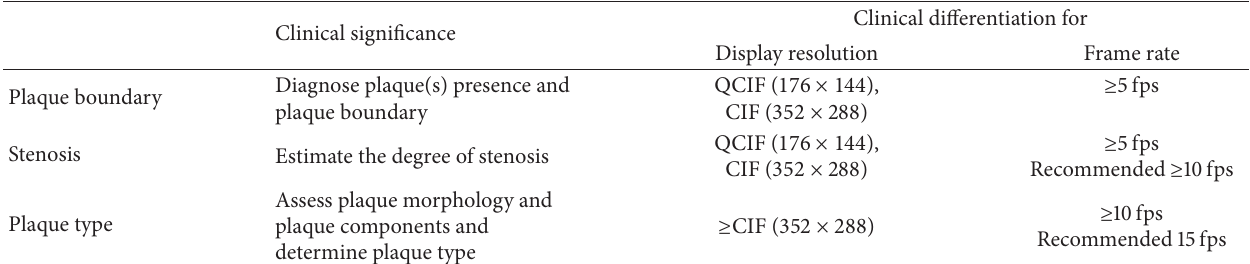
Table 3: Clinical evaluation criteria and associated encoding